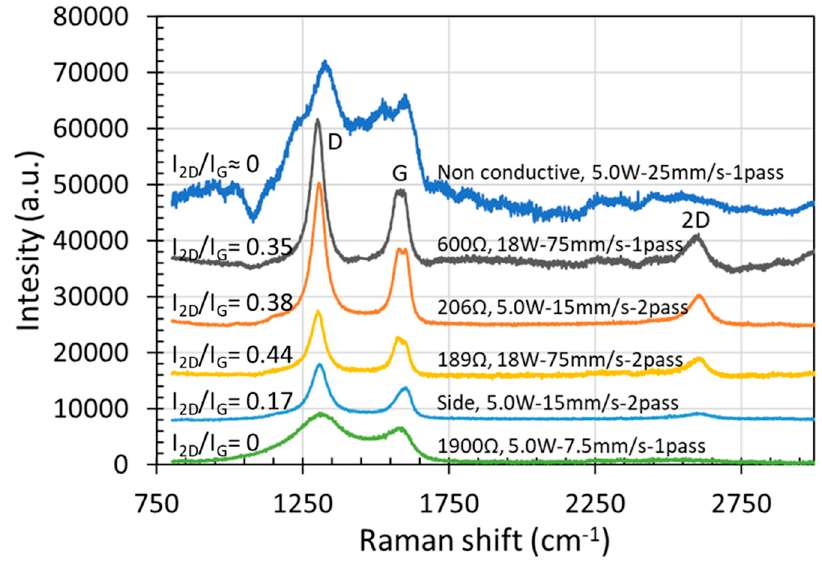
Figure 10. Raman spectra of the porous structures produced under various laser irradiation condi- tions.